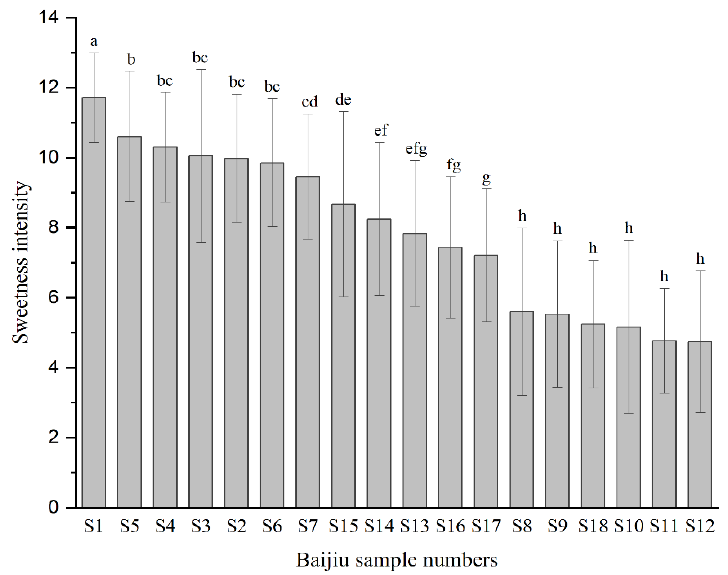
Figure 1. Sweetness intensities of the 18 Baijiu samples. Sweetness intensity was evaluated by 12 sensory panelists using a scale from 0 (none) to 15 (strong). Values are the mean ± standard deviation (SD). The different letters indicate significant differences at p < 0.05. Table 1. Sweetness intensity of the fractions prepared from Baijiu sample